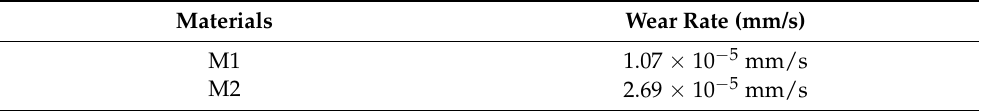
Table 6. Pin wear indicator (thickness loss per unit time) calculated for M1 and